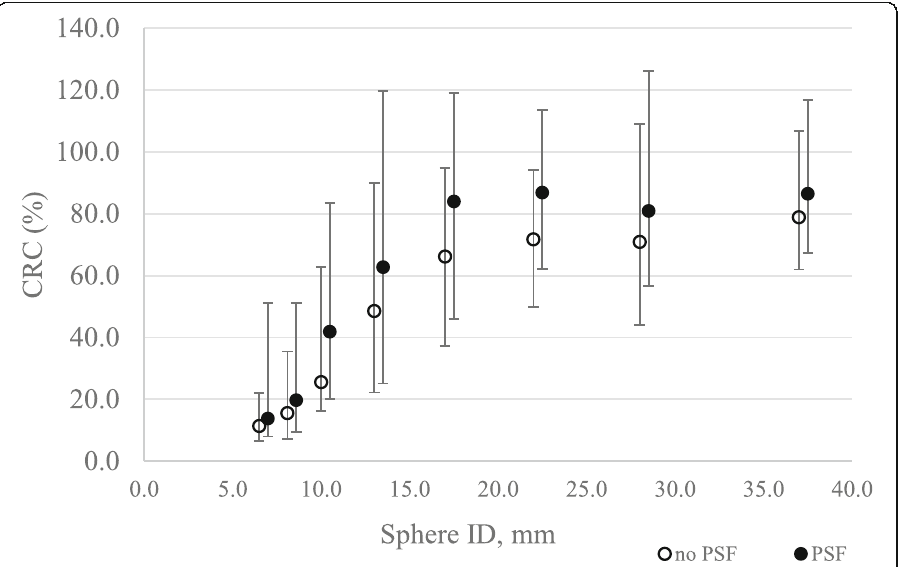
Fig. 2 Box plots of CRC values as a function of sphere ID and PSF for visible spheres. Outliers and extremes are points higher than the value of the 75th percentile plus 1.5 or 3 times the interquartile distance, or lower than the value of the 25th percentile minus 1.5 or 3 times the interquartile distance,